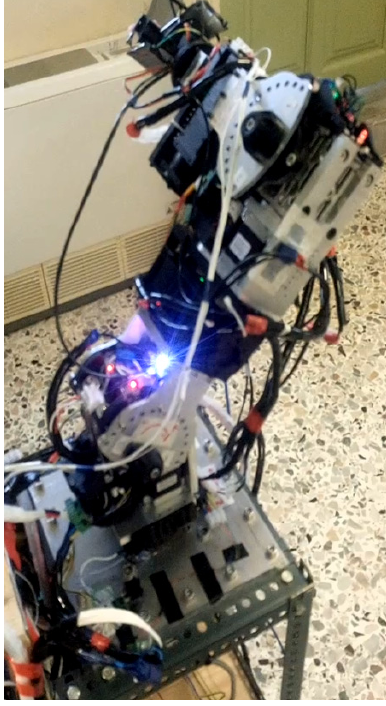
( b ) Figure 26. Comparison of the required joint velocities ( a ) and joint current usage ( b ) for the best anat- omy and the worst performing anatomy under the Effective Mass performance index for Task 4. The results presented in Figures 25 and 26 were expected, given the theorical inter- pretation of the considered measures, and signify the validity of the presented method with respect to the derivation of the optimal anatomy. As seen in Figure 25, the best anat- omy with respect to the MMA and the MVR requires minimum joint current utilization in order for the end effector to apply the required force along the path, and minimum joint velocities require for the end effector to achieve the required velocity along the path, as